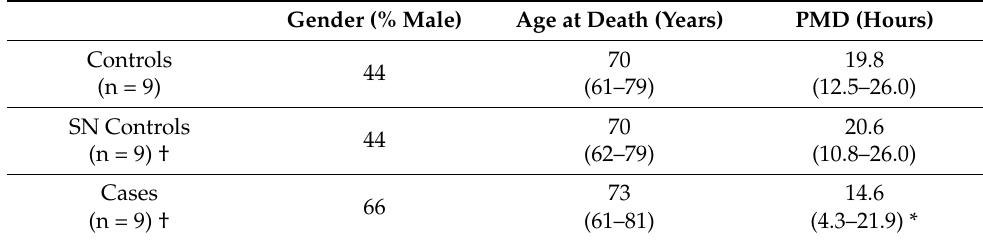
Table 1. Comparison of Brain Bank Groups.